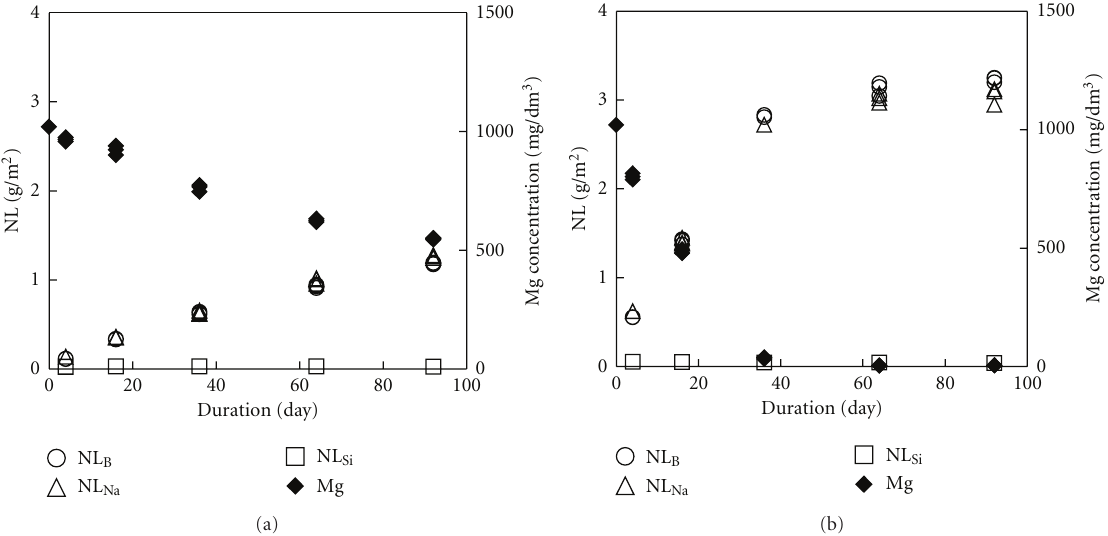
Figure 3: The NL for B, Na, Si, and the concentration of Mg in the leachates versus time for the tests in MgCl 2 solution at (a) 60 ◦ C and (b) 90 ◦